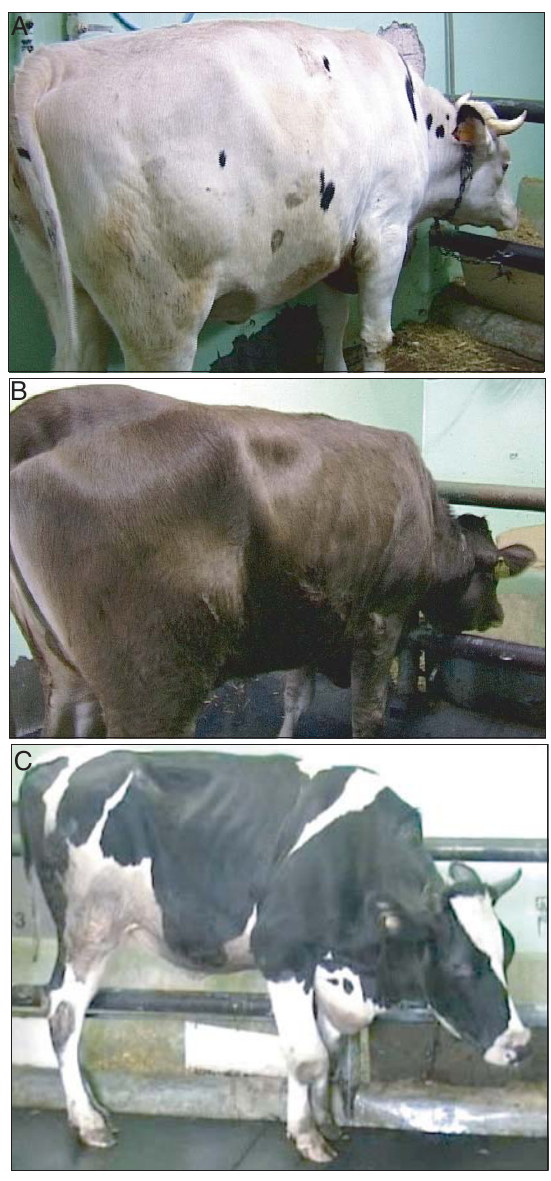
Figure 1. BSE and BASE infected cattle. (A) BSE Friesian ( # 258) at 670 d.p.i., (B) BASE Alpine brown ( # 995) 600 d.p.i., and (C) BASE Friesian ( # 261) 585 d.p.i. BASE-infected cattle show muscle atrophy particularly severe at the hind limbs and pelvic girdle (B,C), while in BSE- challenged cattle (A) musculature is apparently normal.